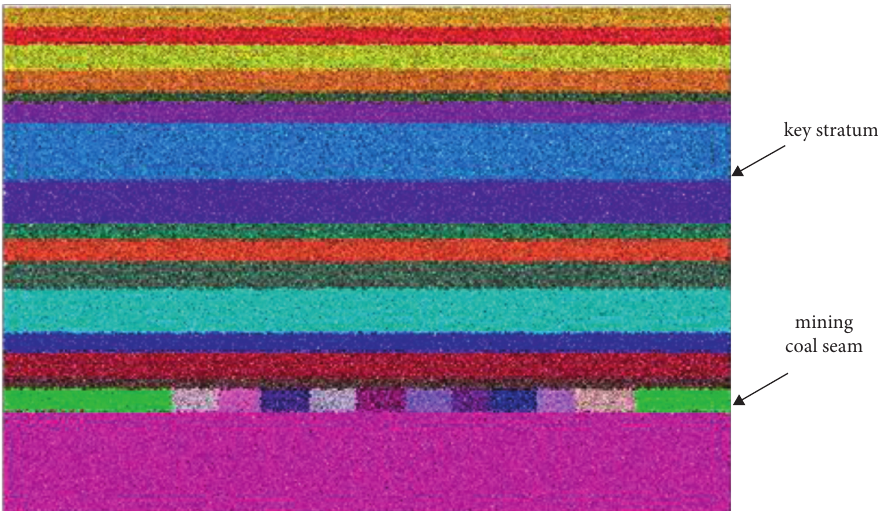
Figure 6: PFC particle flow numerical simulation mining model.